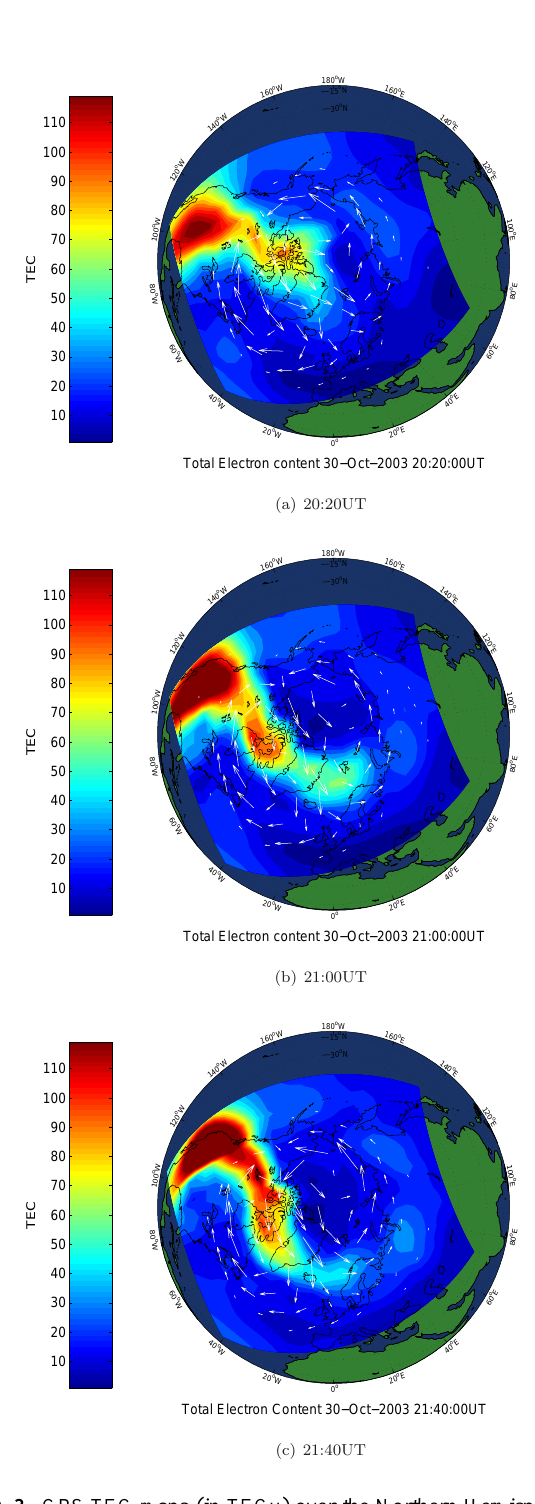
Fig. 3. GPS TEC maps (in TECu) over the Northern Hemisphere showing the plasma transported anti-sunward from the dayside ionosphere across the polar cap, then arriving Northern Europe, for the period of (a) 20:20UT, (b) 21:00UT and (c) 21:40UT on 30 October 2003.